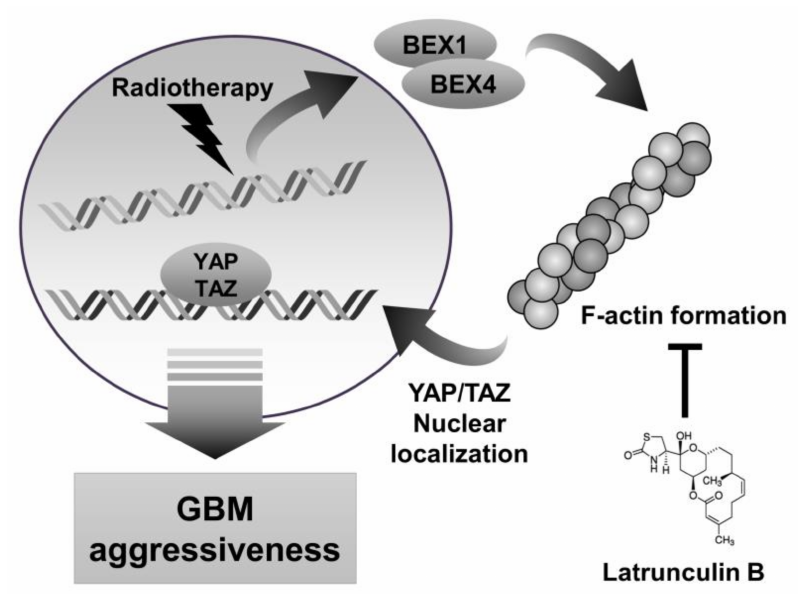
Figure 5. Schematic diagram depicting that inhibition of actin polymerization by latrunculin B reduces GBM aggressiveness. IR-induced BEX1 and BEX4 lead to actin polymerization, which localizes YAP/TAZ to nuclear. YAP/TAZ nuclear translocation induces GBM aggressiveness by activating the downstream target